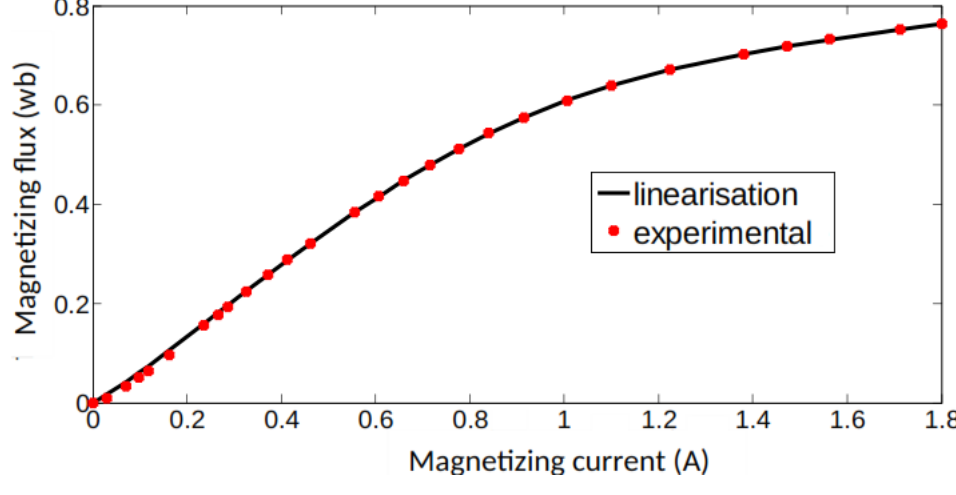
f i λ = Figure 4. Magnetization curve λ m = f ( i m ) . Figure 4. Magnetization curve ( ). m m The machine parameters are: 0.5 Kw, 220/380 V 1500 rpm, 0.75 A , 50 Hz, 2 poles, The machine parameters are: 0.5Kw, 220 / 380V 1500 rpm , 0.75A,50Hz,2 poles, R r = 14.38 Ω R s = 28.59 Ω X r = 19.81 Ω X sm = 20.1 Ω X s = 19.81 Ω , and X s = 19.81 Ω . 14.38 R = R 1 = R 2 = 1000 Ω r